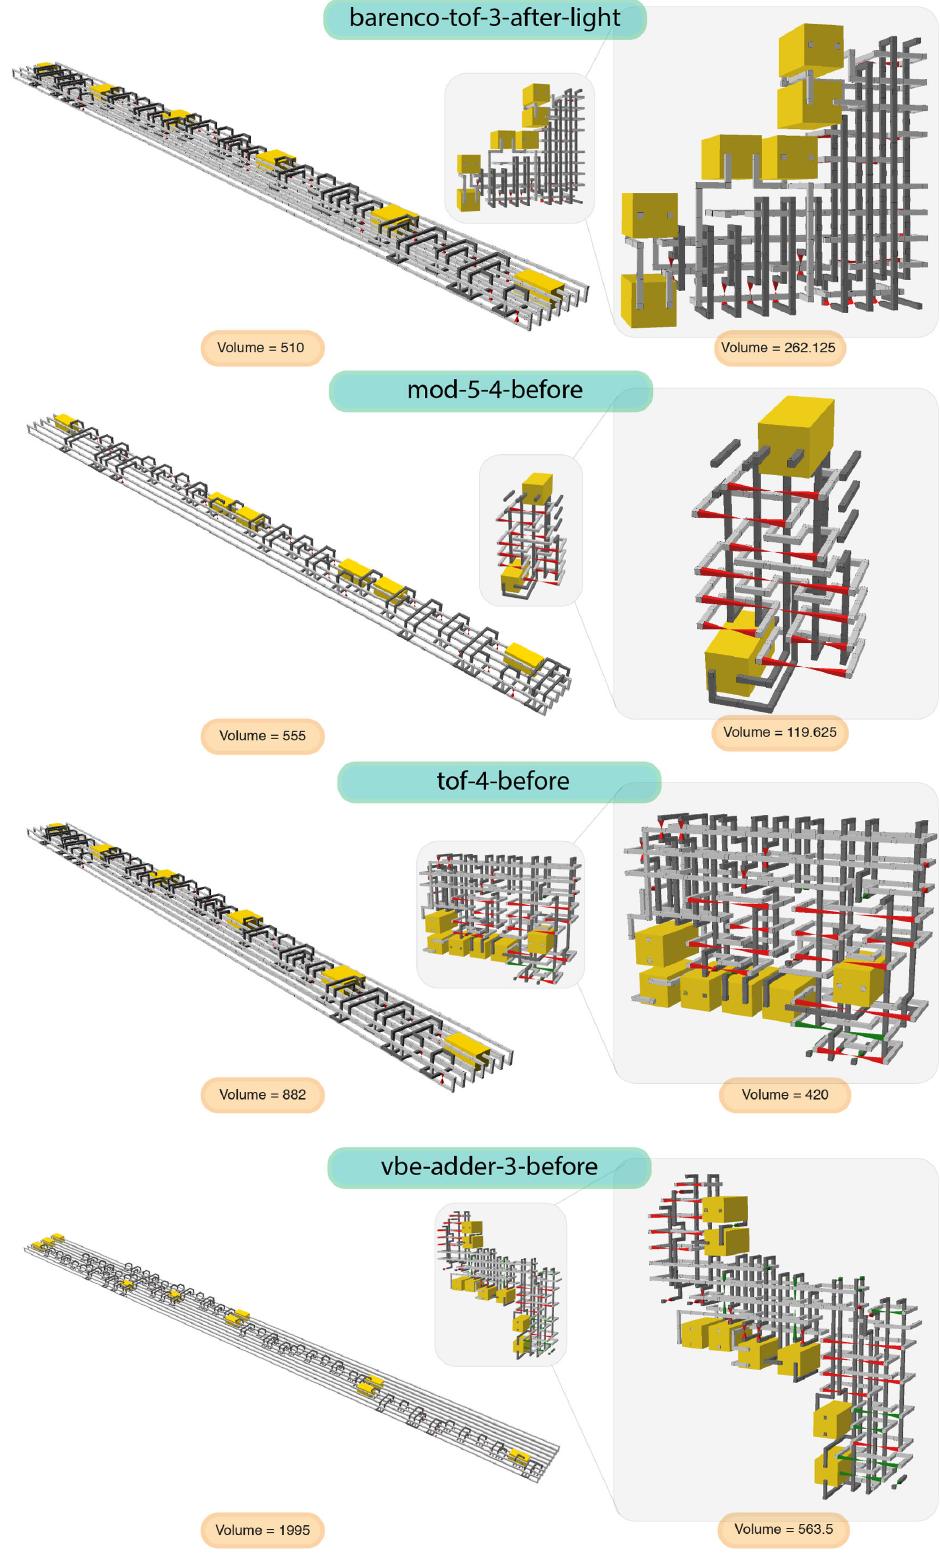
FIG. 8. 3D structures of the benchmarked circuits before and after compression and their respective volumes. We show the scaled structure to be compared with the initial nonreduced circuit and then an enlargement for